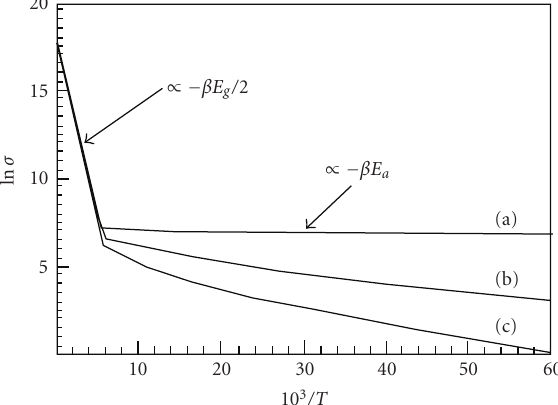
Figure 16: The DC-conductivity is shown for the n-type (or p- type) extrinsic semiconductor where the energy gap E g = 0 . 33eV, the hopping energy for the HOMO (or LUMO) band t = 0 . 2eV, and the activation energy for the polaron hopping of (a) E a = 0 . 001t, (b) E a = 0 . 03t, and (c) E a = 0 . 05t are taken, respectively. N c = P v = 10 8 and n = N D − N A = 10 3 are